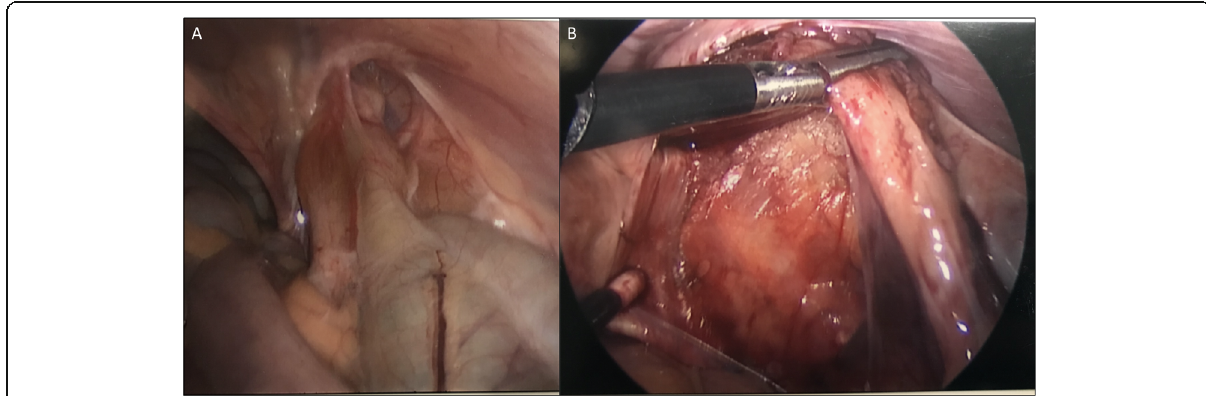
Fig. 4 Laparoscopic images. a Of appendix in right inguinal canal. b Laparoscopic image of dissection of appendix out of canal with vas deferens and testicular vessels